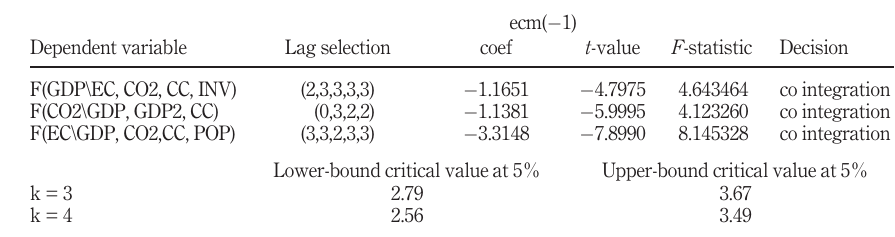
Table II. The bounds test for level relationships